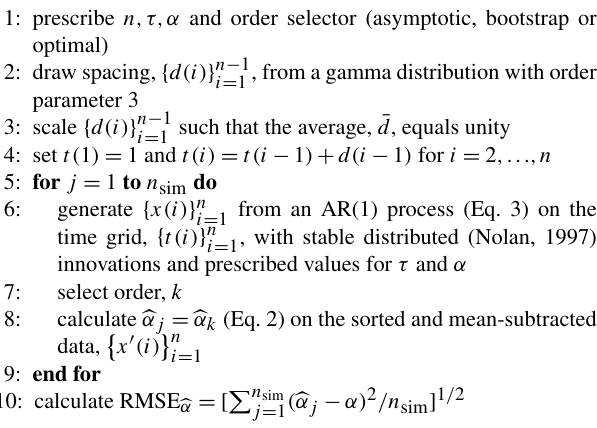
Algorithm 2 Monte Carlo experiment on order selection for the Hill estimator, n sim =